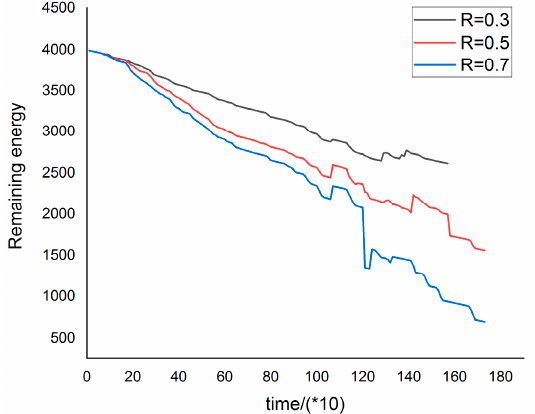
Figure 9. Variation of energy over the period.